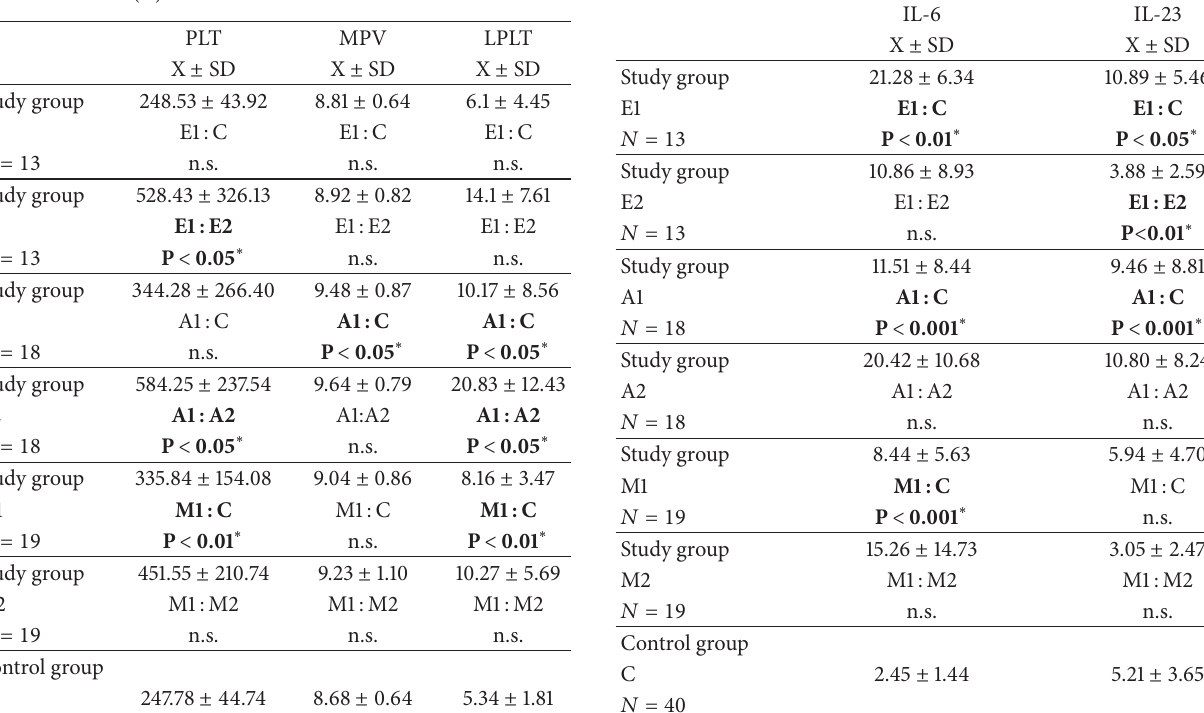
Table 2: The mean platelet count and their morphological parame- ters in patients suffering from gastric cancer—early gastric cancer, E (E1 before surgery, E2 after surgery), advanced cancer with metastasis to lymph nodes, A (A1 before surgery, A2 after surgery), and metastatic tumor, M (M1 before surgery, M2 after surgery) and in normal donors (C).